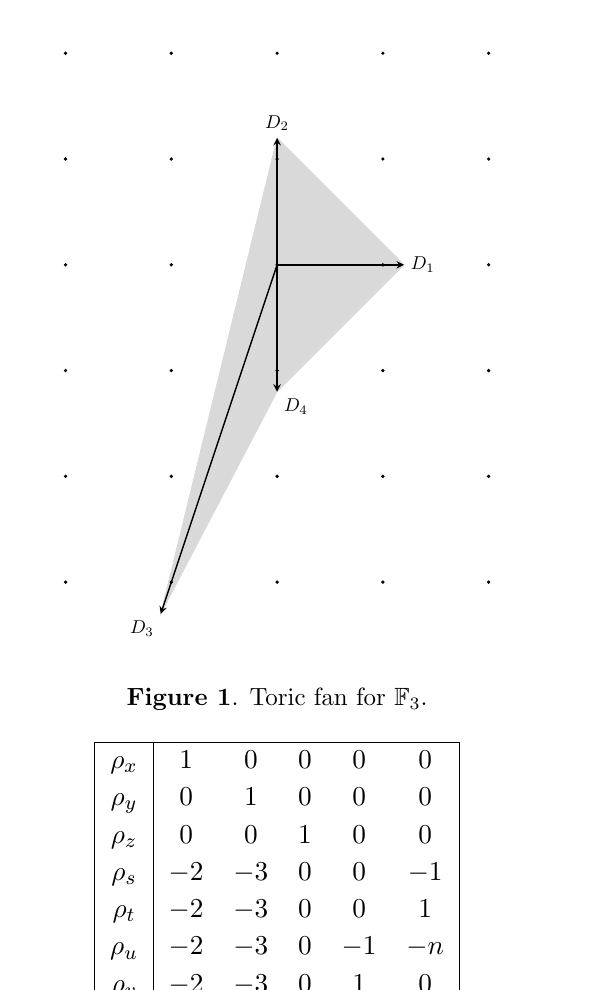
) (cid:8) ( (cid:0) 3 K F )) ! F n n n